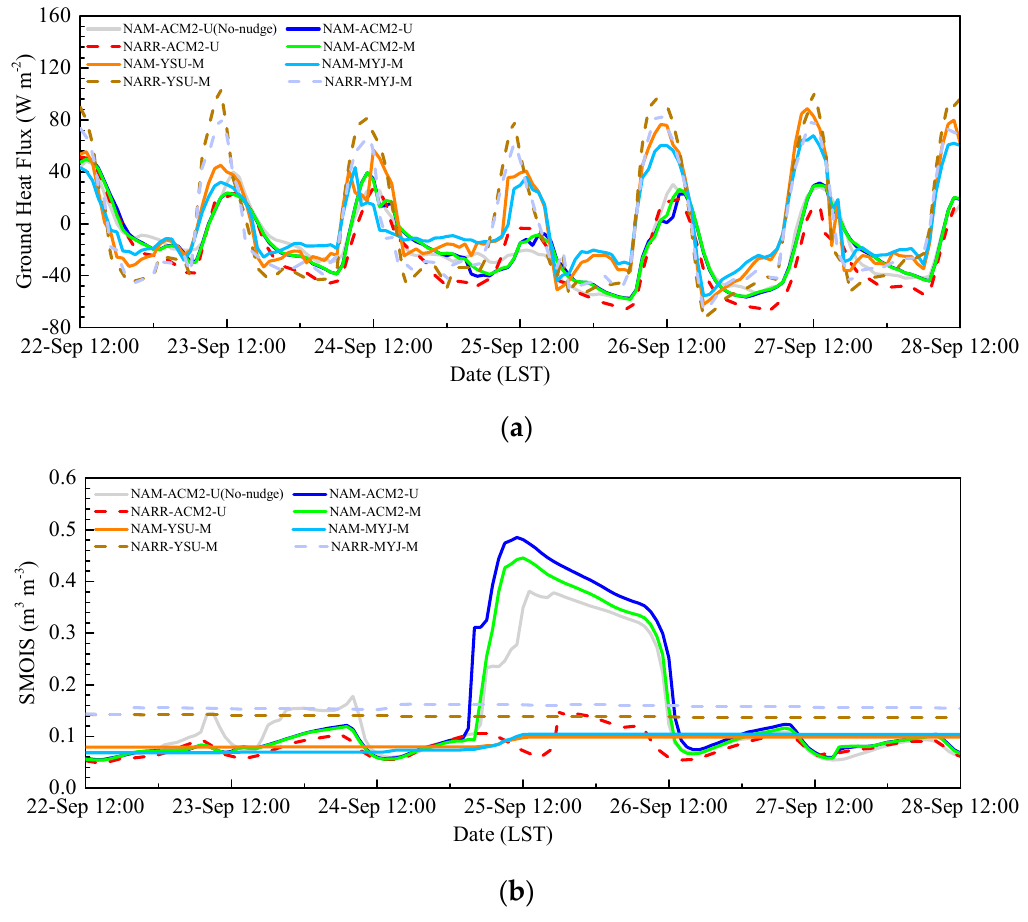
Figure 8. Simulated ( a ) ground heat flux and ( b ) the first layer soil moisture over the observation site.